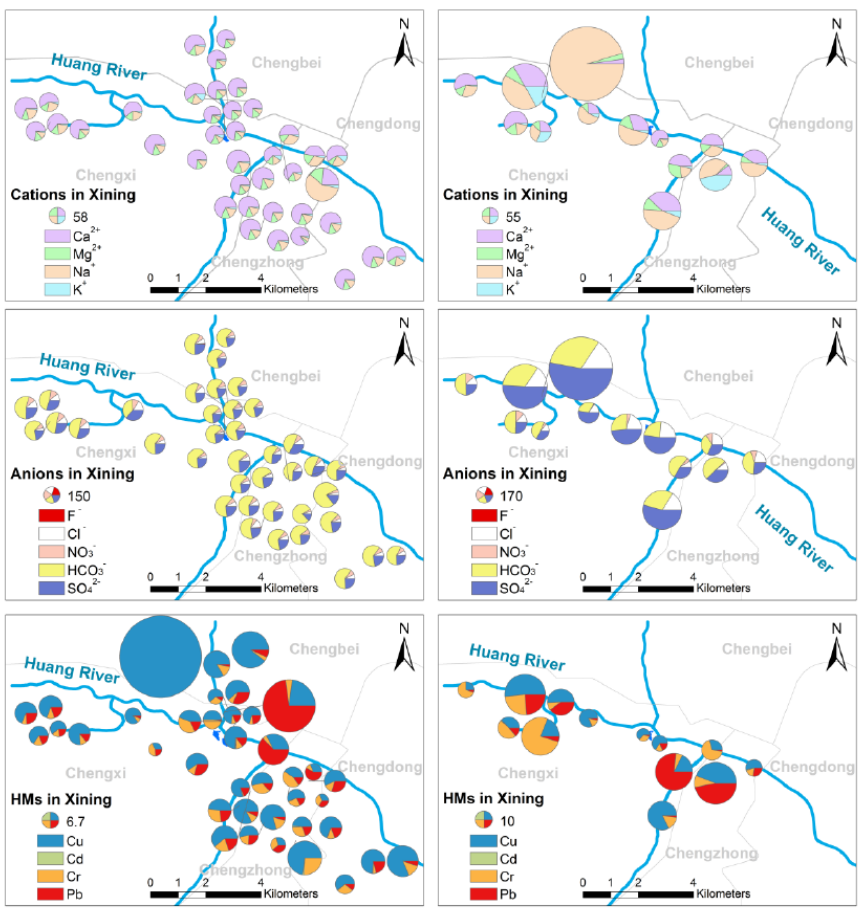
Figure 2. Spatial distributions of cations, anions and HMs of DW and SW in Xining. Notes: The left column as Drinking Water and the right column as Surface Water.